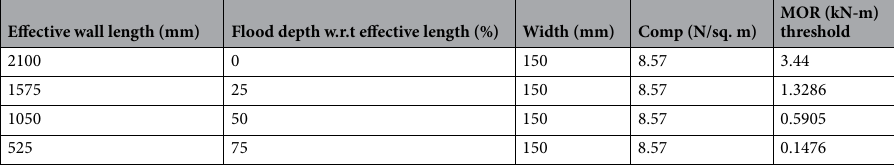
Table 3. MOR due to roof load for various wall sections.